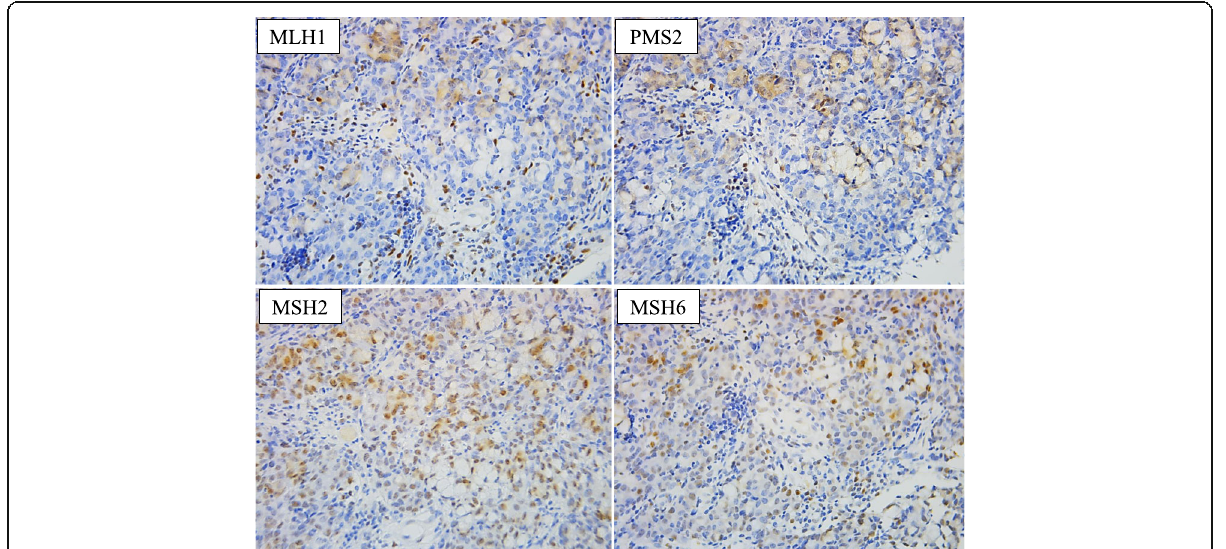
Fig. 5 Immunohistochemical staining of indicated mismatch repair proteins in the biopsy specimen from the primary